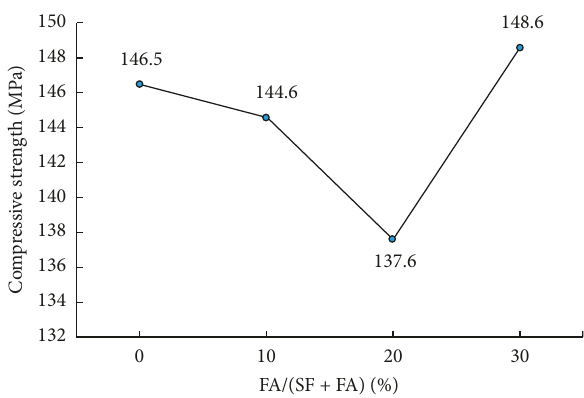
Figure 9: Influence of FA-replaced partial SF on the compressive strength of UHPFRC.